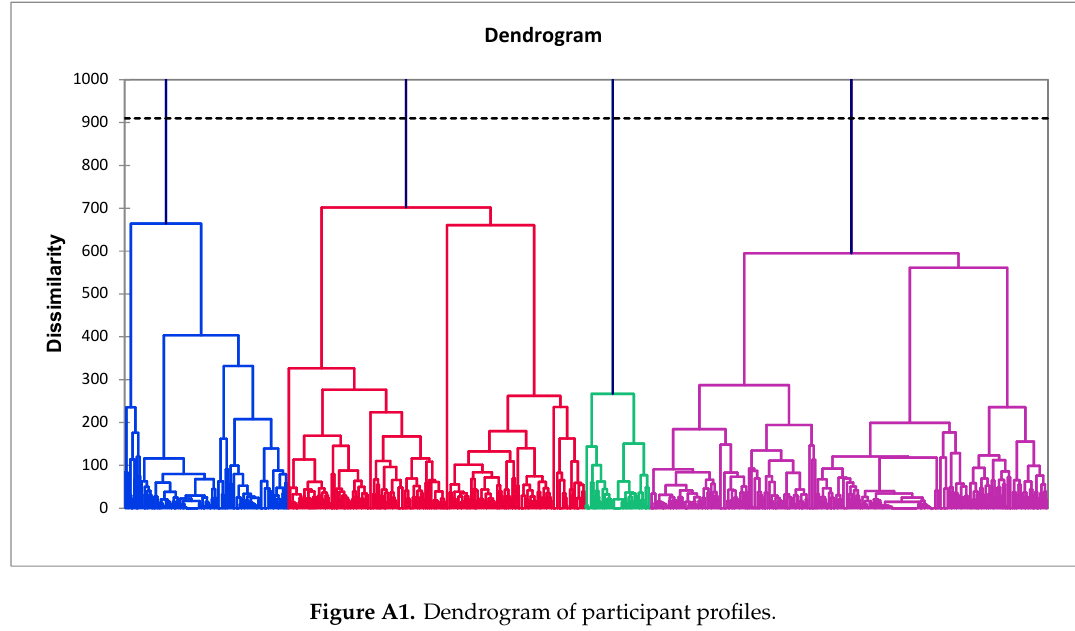
Dendrogram of participant profiles. Urban Sci. 2019 , 3 , x FOR PEER REVIEW